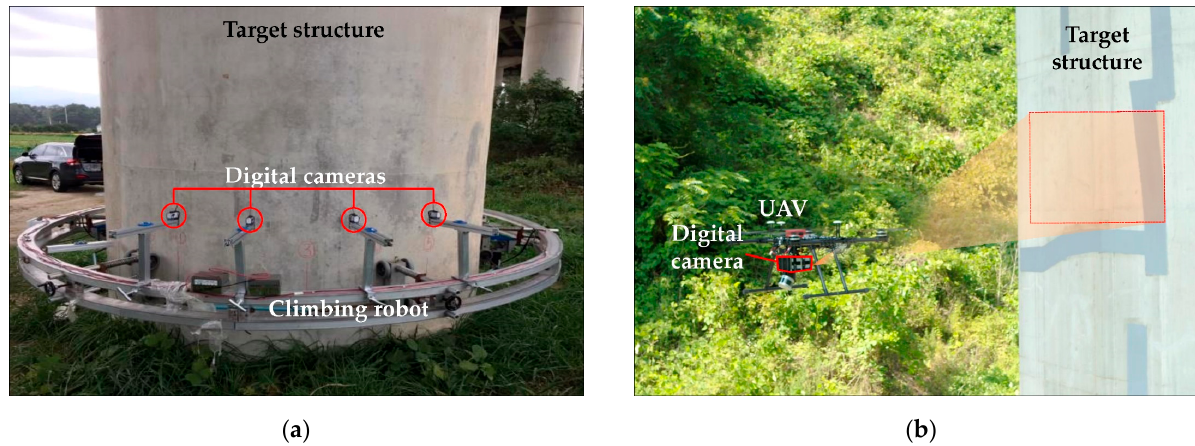
Figure 4. Unmanned robot system for data acquisition: ( a ) climbing robot with multiple digital cameras; ( b ) unmanned arial vehicles with digital camera.